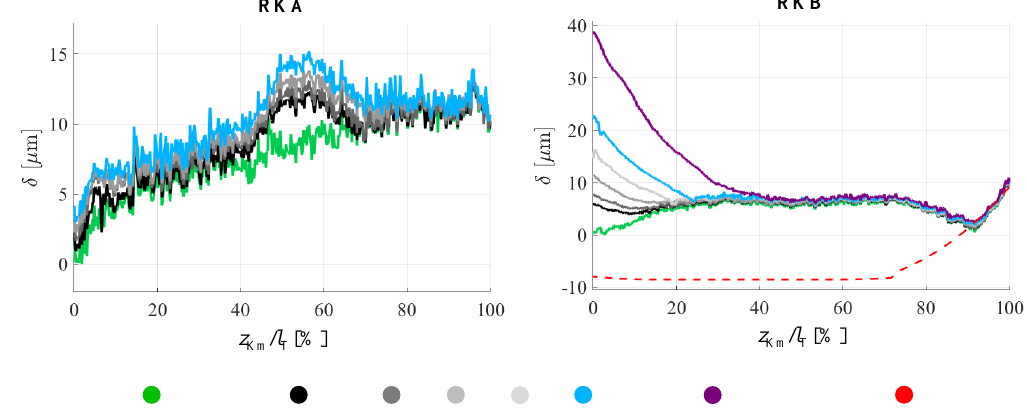
Figure 21. Surface measurement traces for the bushing bores of RKA and